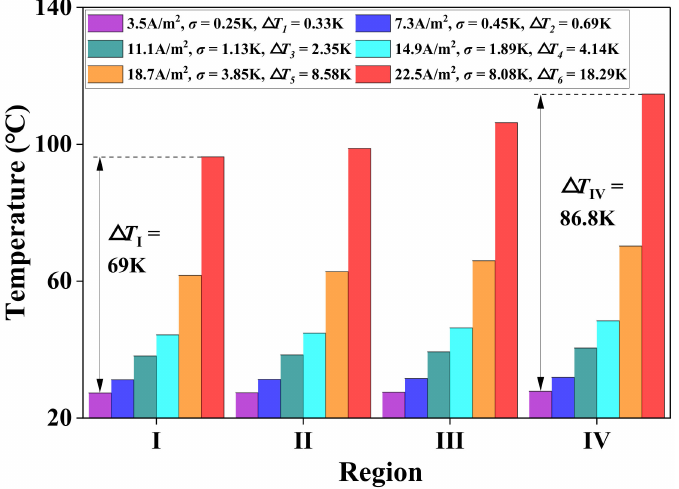
Figure 10. Winding temperature distribution under a wind velocity of 4.7 m/s and different current densities (3.5 A/mm 2 , 7.3 A/mm 2 , 11.1 A/mm 2 , 14.9 A/mm 2 , 18.7 A/mm 2 and 22.5 A/mm 2